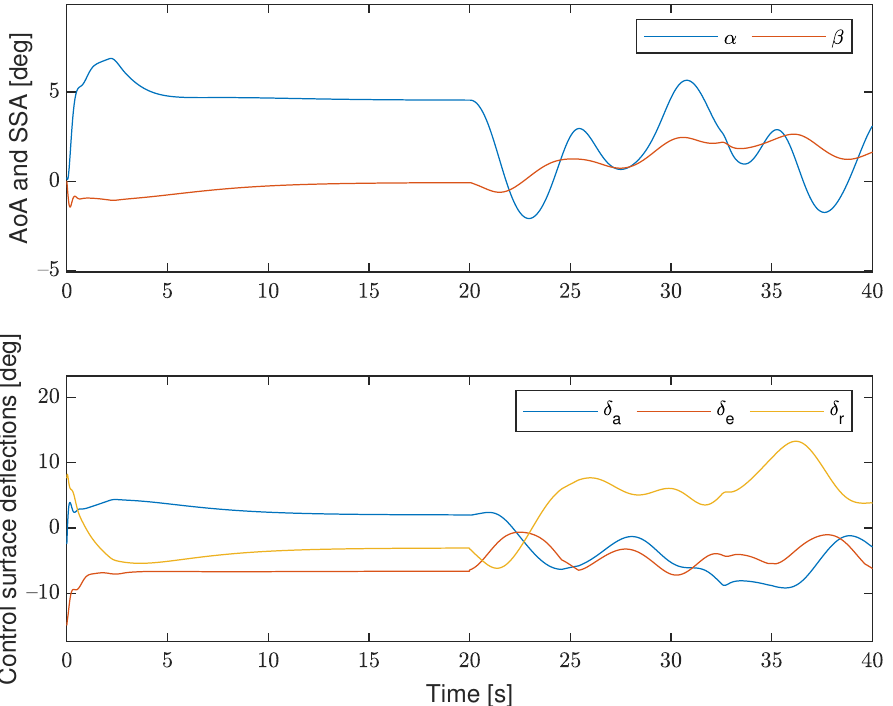
Figure 9. Top : angle of attack α and sideslip angle β ; Bottom : control surface deflections aileron δ a , elevator δ e and rudder δ r .